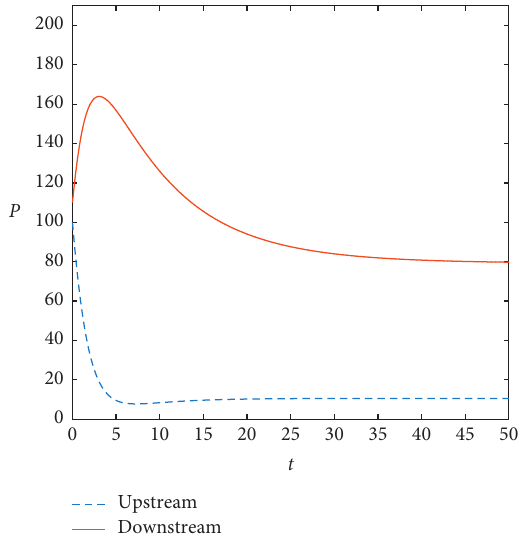
Figure 15: Optimal trajectory of pollution stock under cooperation and non-cooperation when the planning period T � 10.